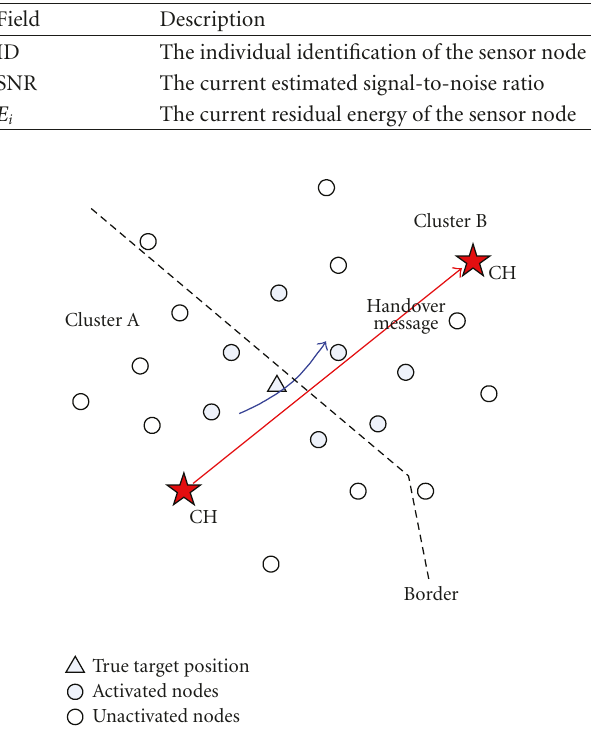
Table 1: The fields contained in TargetInfo message.